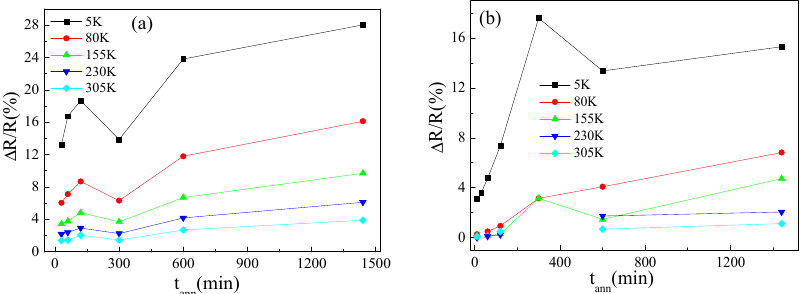
Figure 21. Effect of annealing time on Giant Magnetoresistance (GMR) effect measured in Cu 80 Co 20 ( a ) and Cu 95 Co 5 ( b ) microwires at different temperatures. Reproduced from reference [85], Figure 7a,c. From X-ray diffraction (XRD) spectra we identified two phases: the main one, fcc Cu phase (lattice parameter 3.61 Ǻ ), found in all samples and small amount of hcp Co phase (lattice parameters